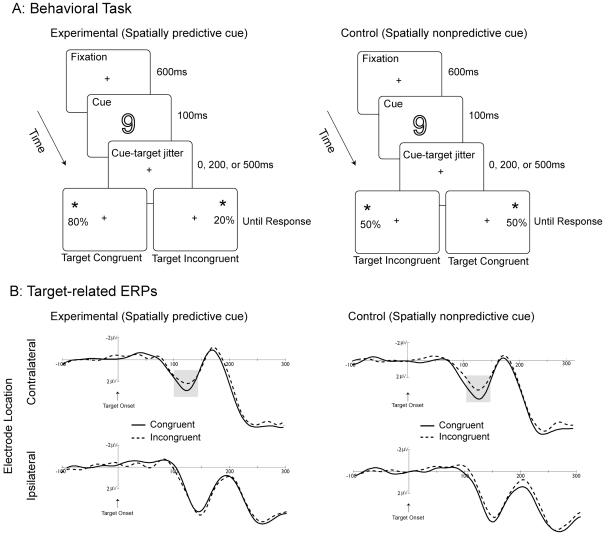
Stimuli and Results.
1A: Example sequence of trial events and illustration of stimuli for the experimental and control conditions. Fixation display in duration of 600 ms was followed by a presentation of the central number cue (3 or 9) in duration of 100 ms. The target (occurring in either left or right upper visual field) demanding a detection response appeared after 0, 200 or 500 ms. The stimuli are not drawn to scale. 1B: Target-related ERPs. Target related modulation of P1 amplitude for experimental and control conditions as a function of electrode site and cue-target congruency averaged across posterior occipital electrodes P5, P7, PO7, and PO3 on the left, and P6, P8, PO8, and PO4 on the right.